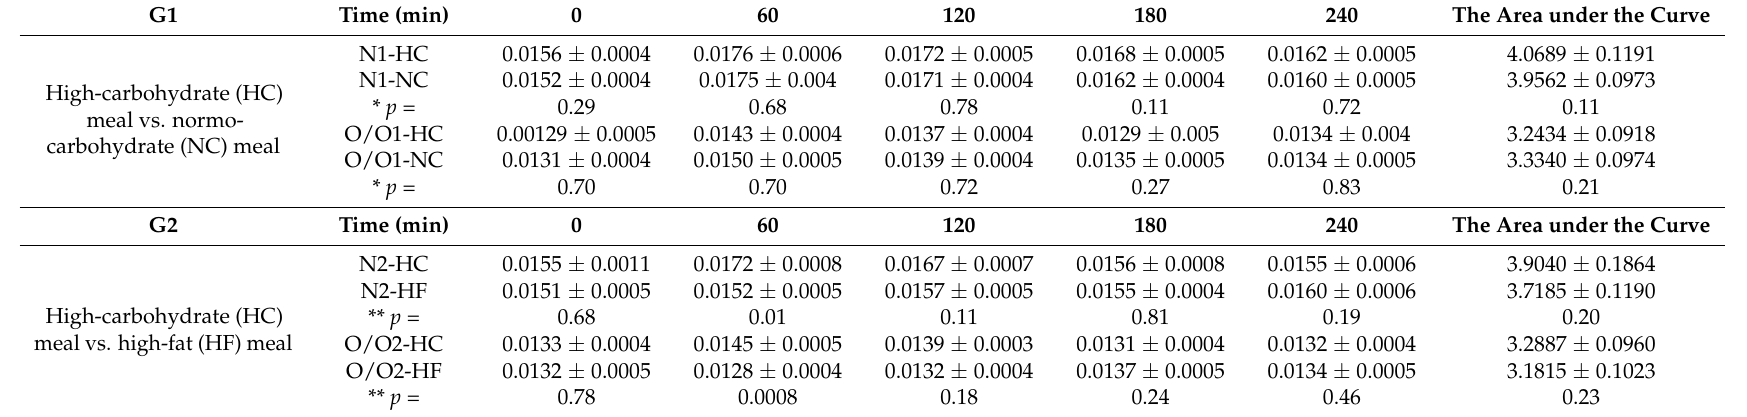
Table 3. Energy expenditure (kcal/kg/min) in men from Group I (G1, with normal body weight N1 and with overweight/obesity O/O1) on fasting (0 min) and in crossover trials after intake (60–240 min) of high carbohydrate (HC) meal and normo-carbohydrate (NC) meal and men from Group II (G2, with normal body weight N2 and with overweight/obesity O/O2) on fasting (0 min) and in crossover trials after intake (30–240 min) of high carbohydrate (HC) meal and high fat (HF) meal. G1 Time (min) 0 240 The Area under the Curve High-carbohydrate (HC) meal vs. normo- carbohydrate (NC)